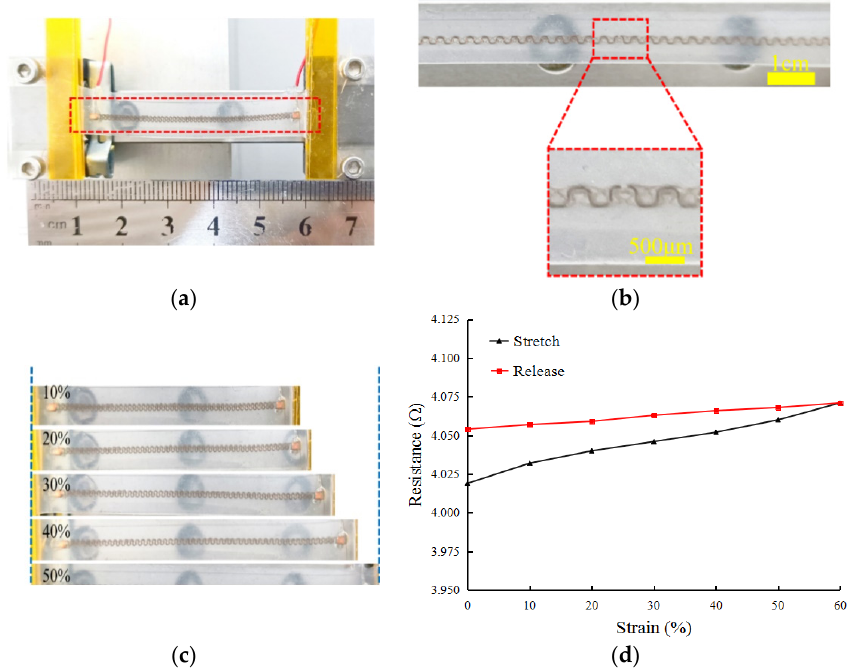
Figure 10. Tensile testing of single electrodes. ( a ) Tensile test bench; ( b ) tensile test (strain 10–50%); ( c ) electrode fracture (strain 60%); ( d ) resistance strain characteristic curve.